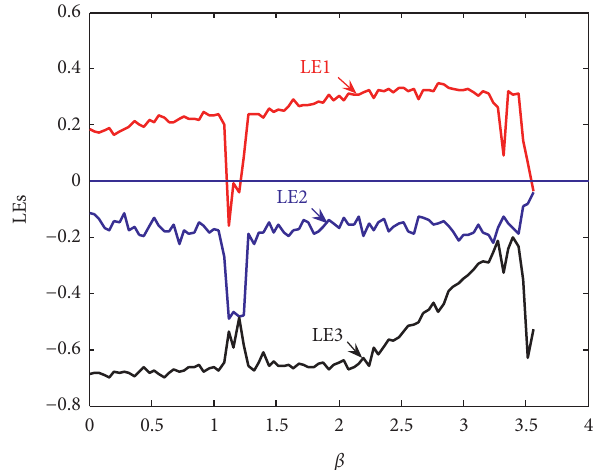
Figure 13: x – n sequence diagram which denotes that the system is periodic when β � 1.2.